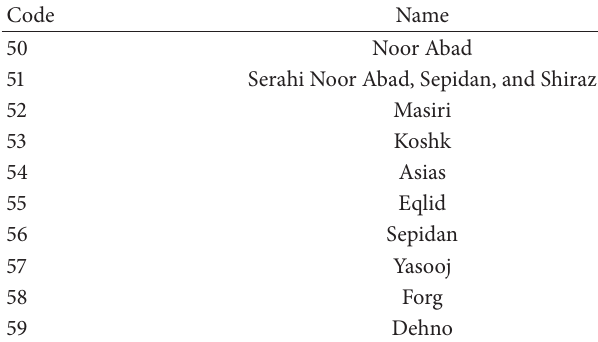
Table 5: List of nodes and their names in road network located in the Iranian province of